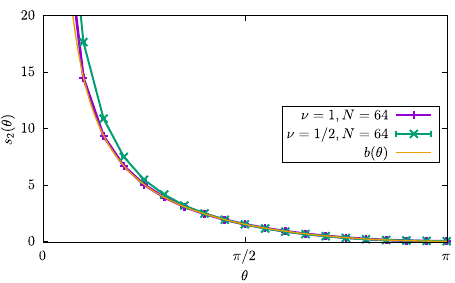
Fig. 3 Comparing the shape dependence of fl uctuations and entanglement. Corner contribution s 2 ( θ ) to the second entanglement Rényi entropy for quantum Hall states as a function of the subregion ’ s corner angle, obtained using Monte Carlo simulations at fi llings ν = 1 and 1/2 with N = 64 particles. The solid orange line corresponds to the super-universal fl uctuation function, Eq. (4). All curves have been normalized to the unit second derivative at θ = π . As in the case of fl uctuations, the boundary law contribution has been removed. The error bars are of statistical origin, as described in the “ Methods